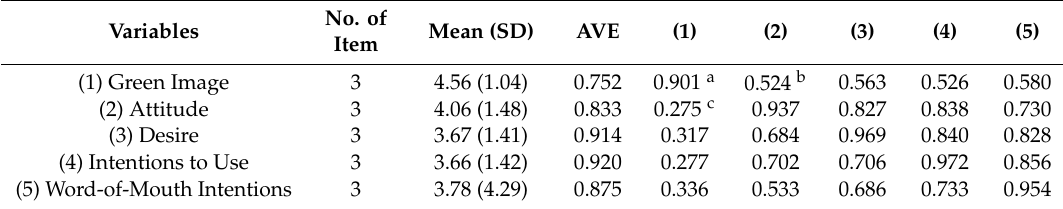
Table 2. Descriptive statistics and associated measures.